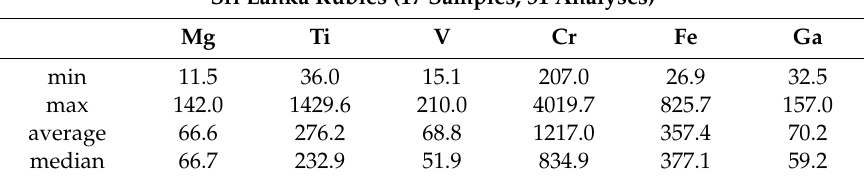
Table 14. Correlation table for trace elements of Sri Lankan blue and pink sapphires and rubies.